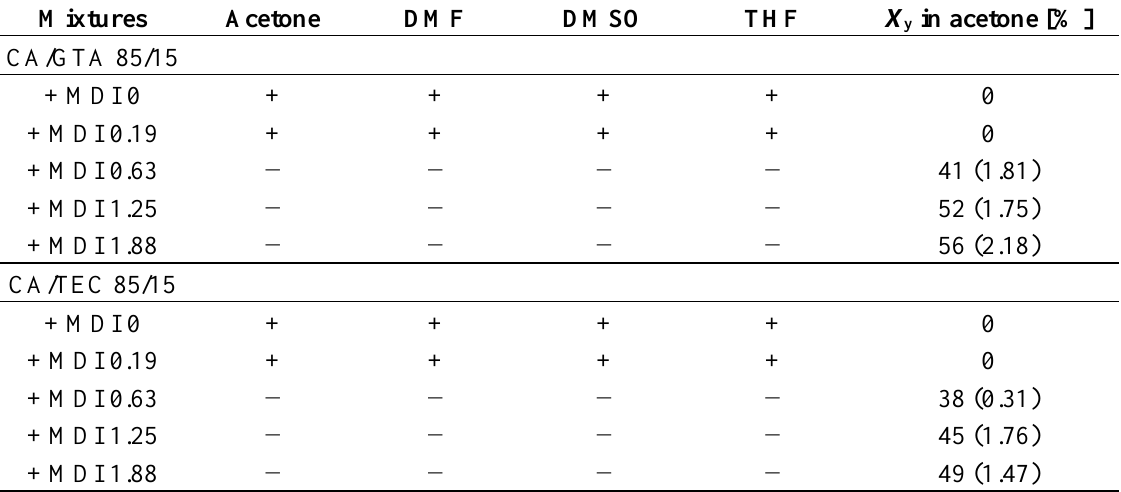
Table 3. Solubility characteristics and crosslinking yield (determined in acetone) with standard deviation in parenthesis for CA/GTA/MDI and